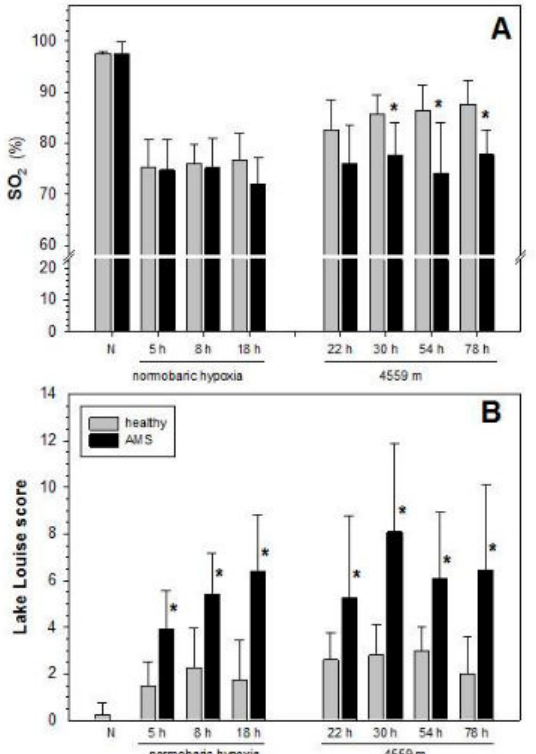
Figure 5. Time course of change in SO 2 ( A ) and in the Lake Louise score ( B ) in controls and individuals developing AMS during normobaric hypoxia and at the Capanna Margherita (4559 m). Data on normobaric hypoxia are from a study on e ff ects of remote ischemic pre-conditioning from 6 controls and 8 subjects with AMS reported in [17,59,60], those from exposure to high-altitude (4559 m) are from 6 controls and 8 subjects with AMS as reported in [41]. Oxygen saturation (SO 2 ) was measured by pulse-oximetry. Mean values ± SD; N: normoxia; * indicates di ff erence between controls and